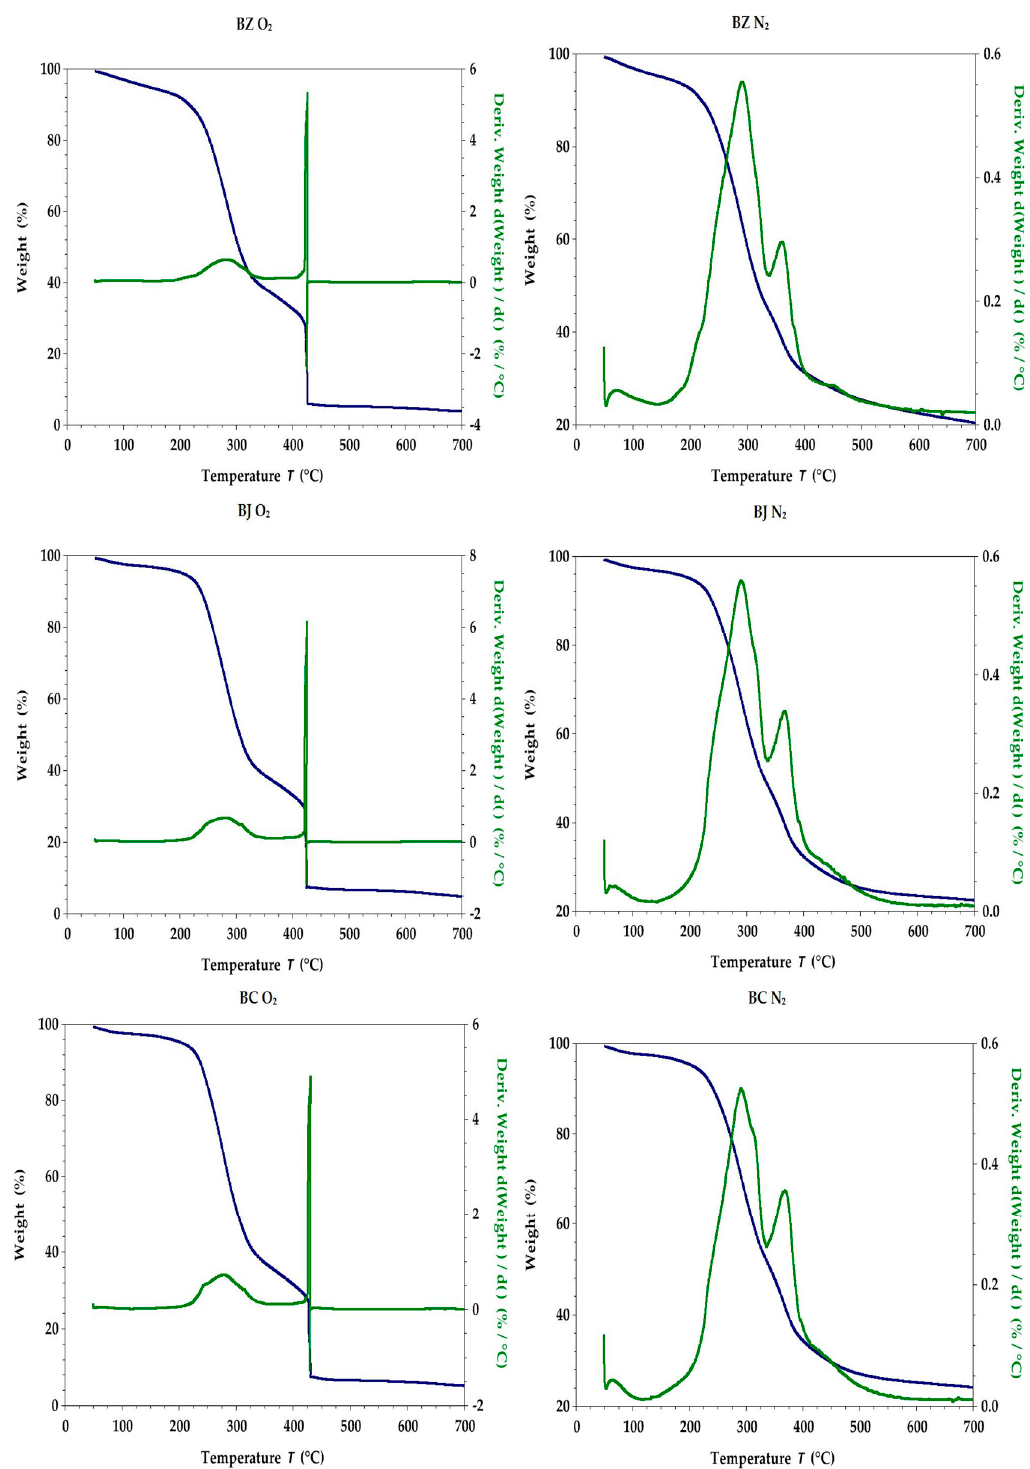
Figure 1. Thermogravimetry/derivative thermogravimetry (TG/DTG) curves of Brazilian green (BZ), light roasted (BJ) and dark roasted (BC) coffee samples in oxygen (O 2 ) and nitrogen (N 2 ) atmospheres. The profiles of the TG and DTG curves of samples analysed in nitrogen atmosphere were determined. In this case, we can only distinguish the following three phases: one from 50 to 150 ◦ C, next from 150 to 335 ◦ C and last from 335 to 700 ◦ C. In the nitrogen atmosphere, the weight loss rate was slower than in the oxygen. The first mild